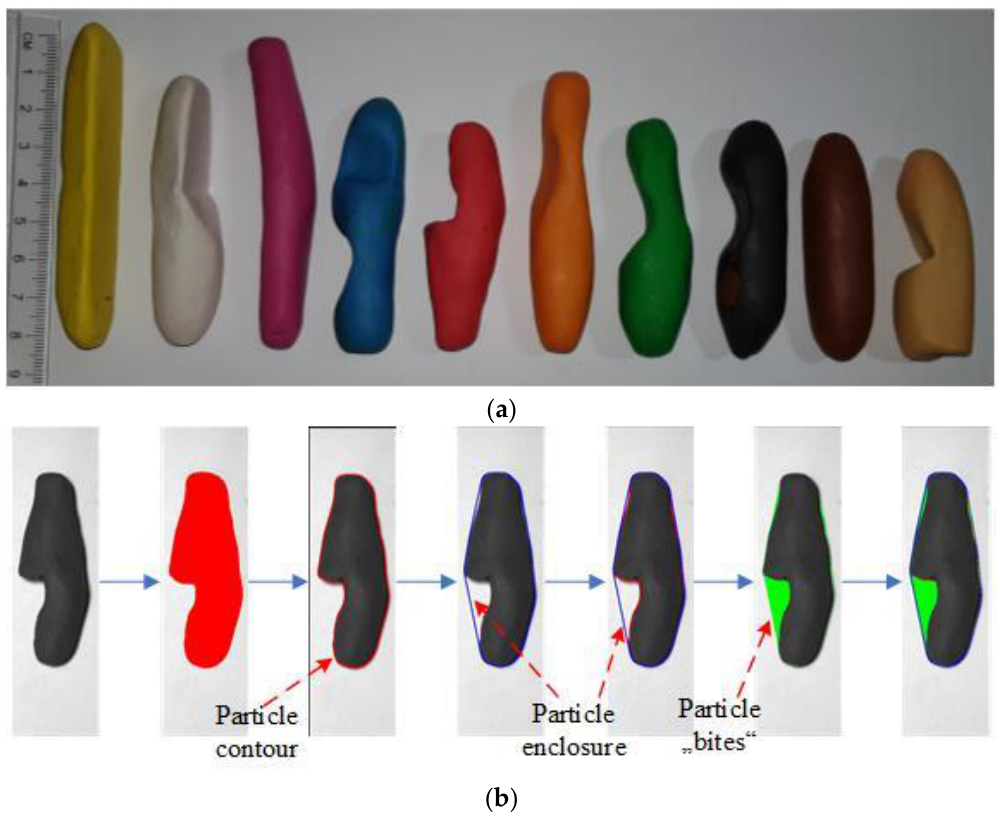
Figure 14. ( a ) Models of analyzed pellets; ( b ) distinguishing of shape parameters of analyzed model of pellet.